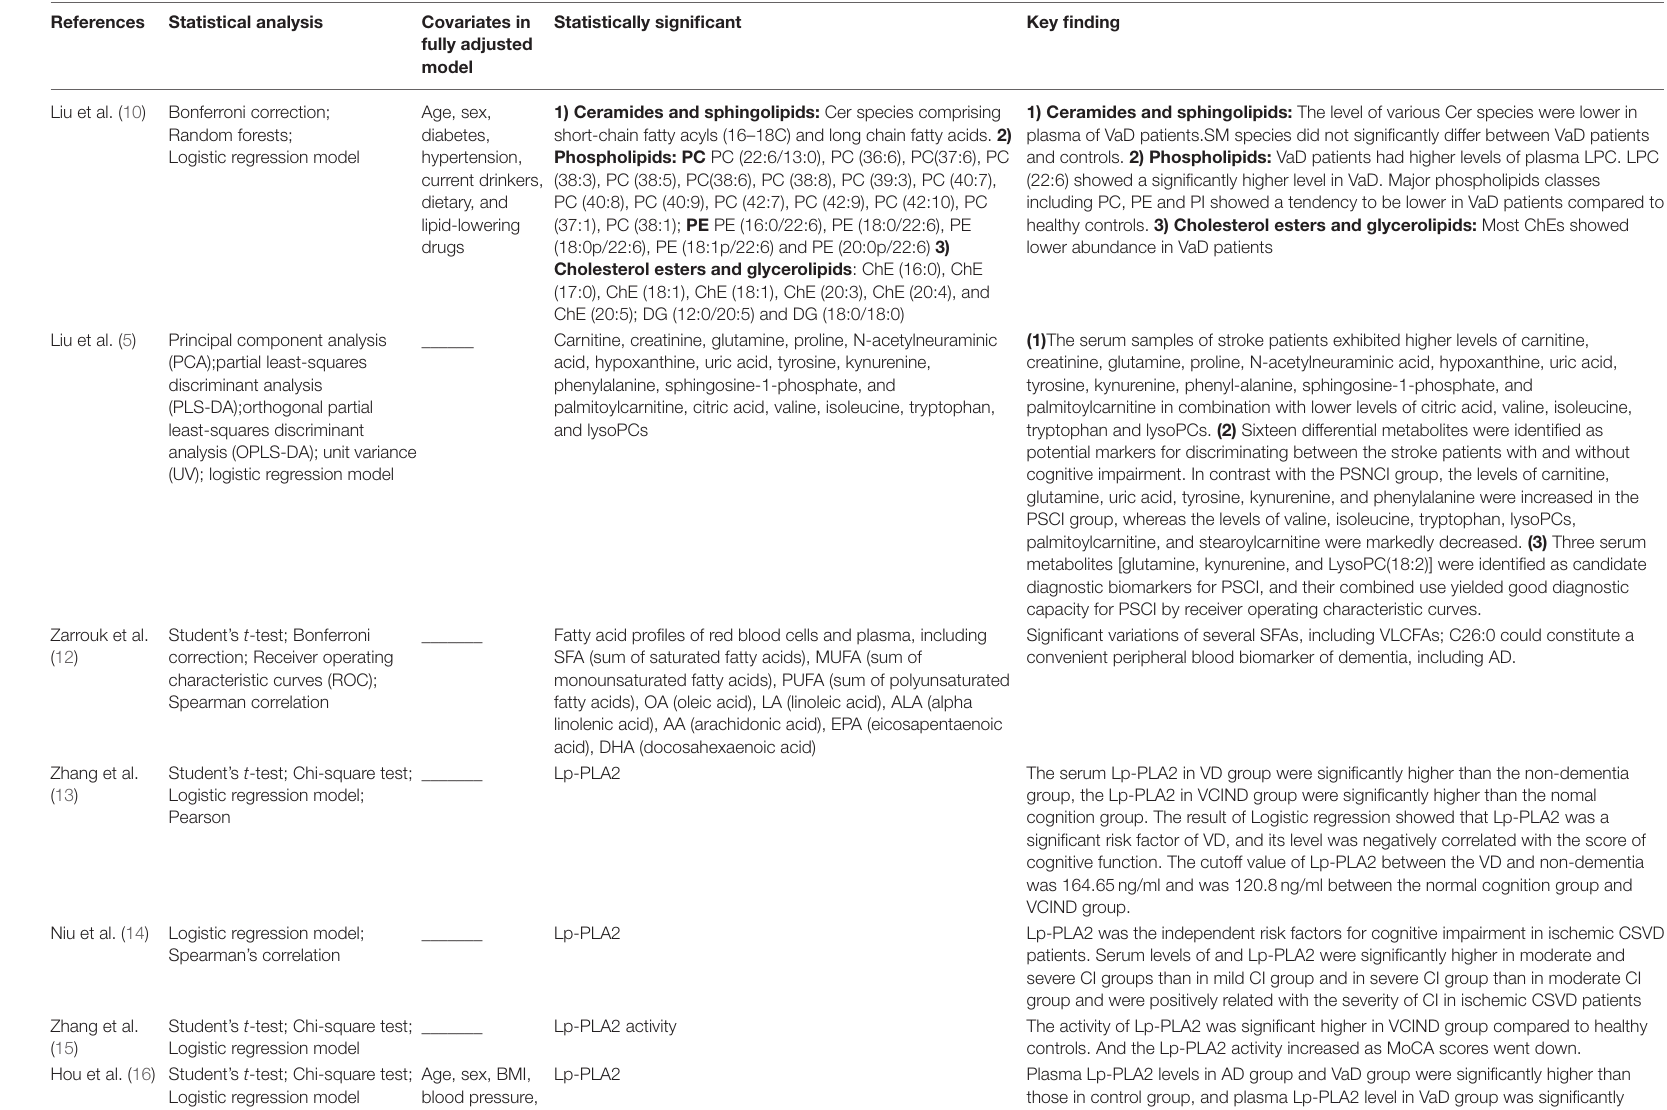
TABLE 2 | Results of analyses associating lipid metabolites with